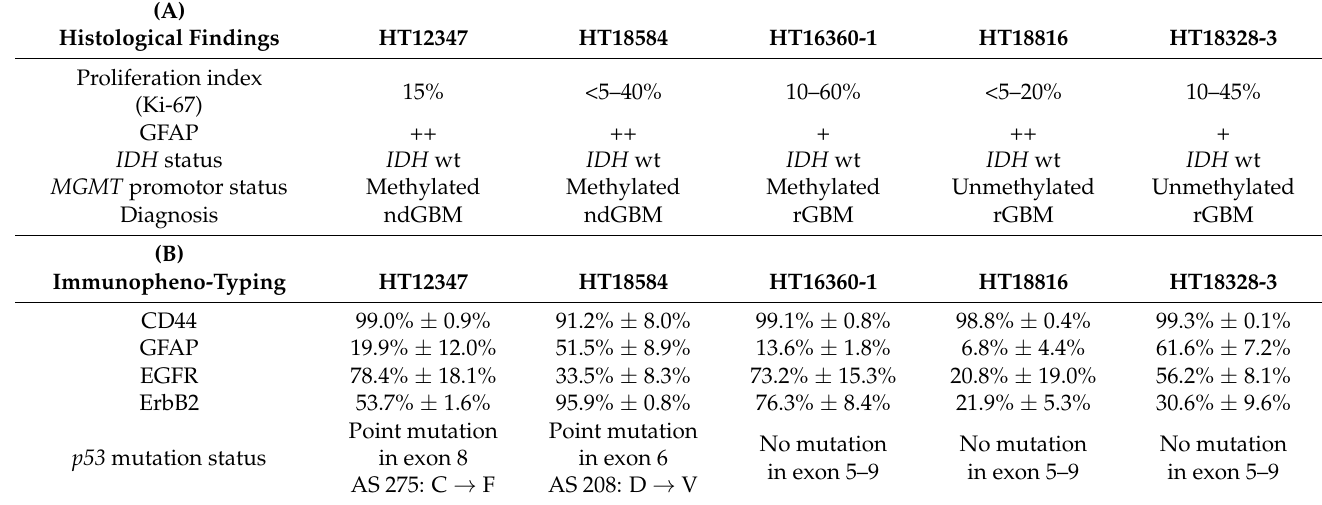
Table 1. Characterization of cell cultures. Glioblastoma tissue pathology and immunophenotyping of established primary glioblastoma cultures. ( A ) Histological findings of the glioblastoma tissue were performed in the Department of Neuropathology of the University Hospital Carl Gustav Carus, TU Dresden. ( B ) Expression of CD44, GFAP, EGFR and ErbB2 was determined by flow cytometry from generated primary glioblastoma cultures (N = 3). Furthermore, the p53 mutation status of these primary cultures was identified by